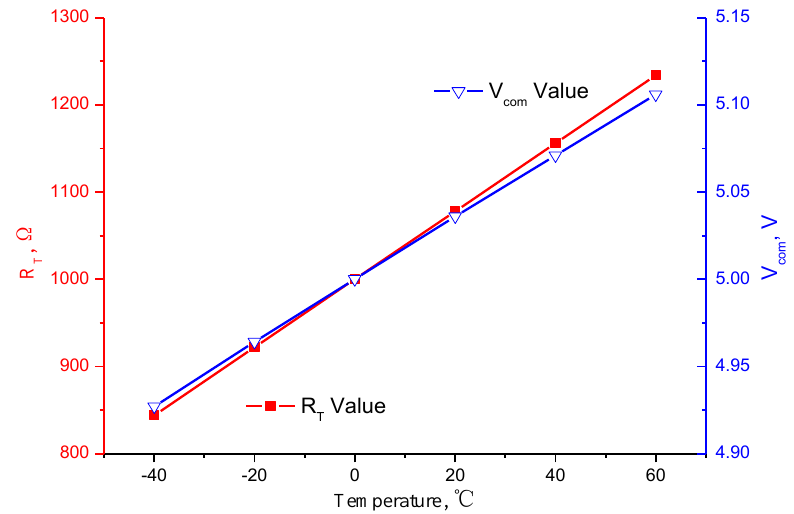
Figure 7. MEMS gyroscope sca le factor temperature compensation circuit simulation result curves. Figure 6. MEMS gyroscope scale factor temperature compensation circuit.